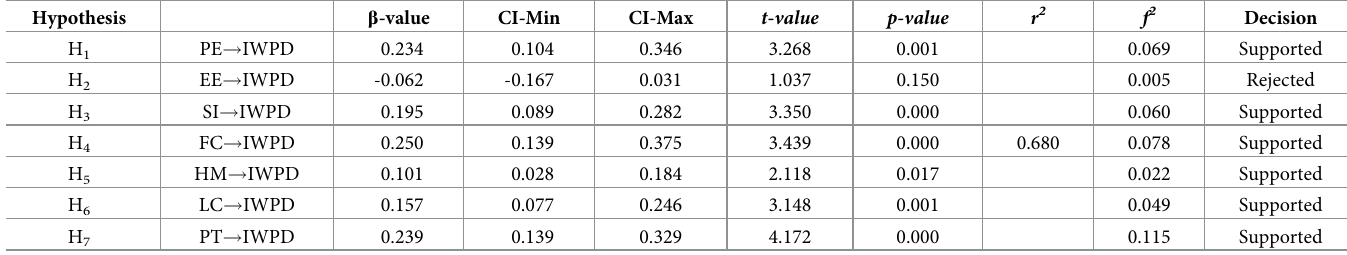
Table 7. Path coefficients. Hypothesis